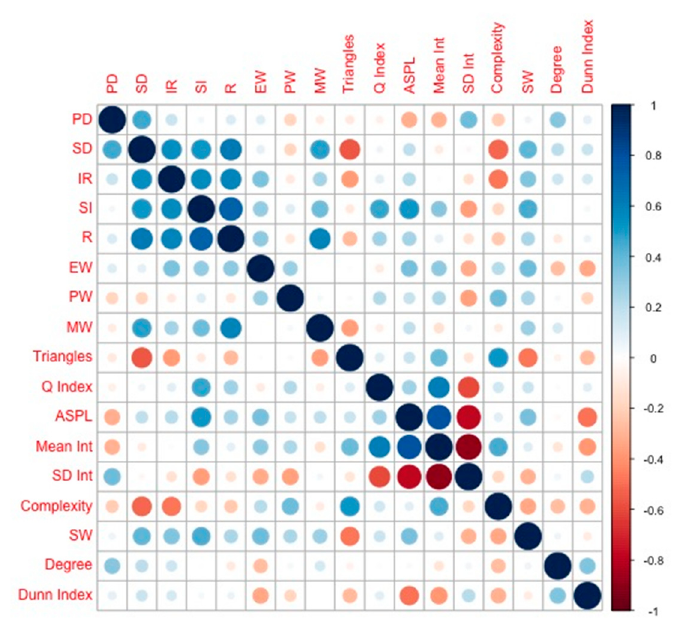
Figure 3. Corrplot of correlation matrix between Quality-of-Life (QoL) dimensions and graph theory measures. PD = personal development, SD = self-determination, IR = interpersonal relations, SI = social inclusion, EW = emotional well-being, PW = personal well-being, MW = material well-being, ASPL = characteristic path length, Mean Int. = Mean Integration, SD Int. = Standard Deviation Integration, and SW = small-worldness.